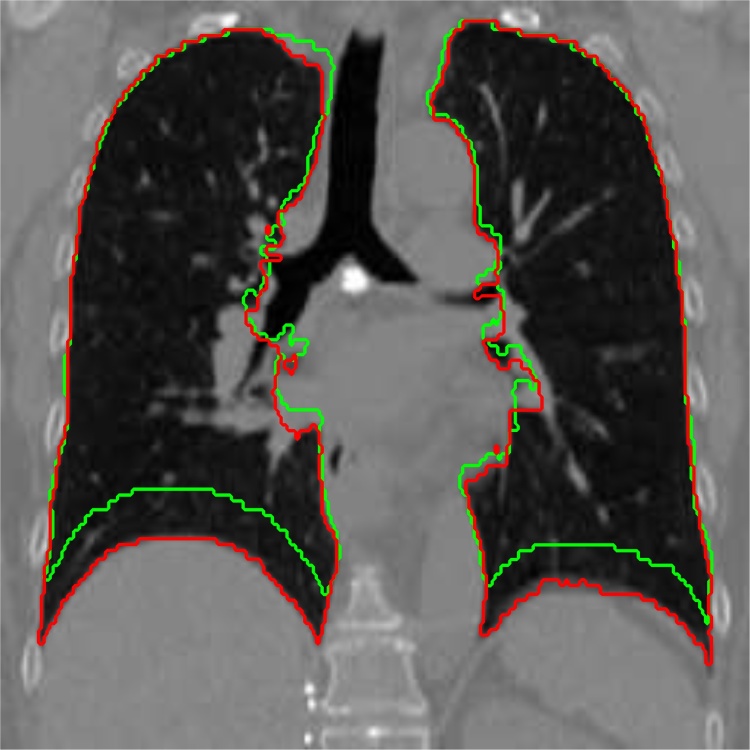
Example of superimposed lung segmentations in inhale state (red) and exhale state (green). Segmentation was performed by experts. The image comes from publicly available Dir-Lab set of CT data described in Castillo et al. (2009). Function ϕL introduced in Eq. (7) takes value 1 inside the red contour and value 0 outside of it. (For interpretation of the references to color in this figure legend, the reader is referred to the web version of this article.)